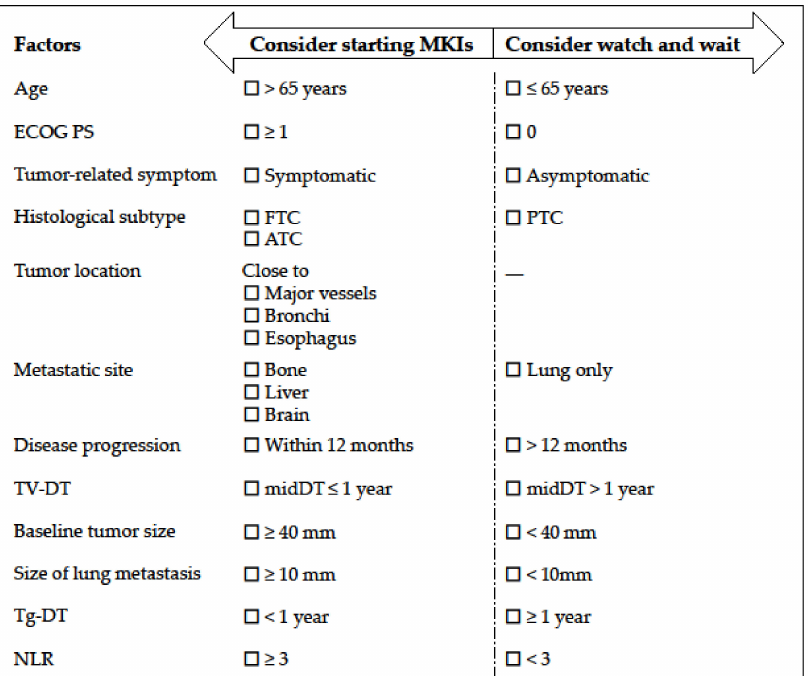
Figure 1. A simple check list of factors which can be potential indications for starting multi-kinase inhibitor treatment for radioactive-iodine refractory differentiated thyroid cancer. ECOG PS, Eastern Cooperative Oncology Group performance status; FTC, follicular thyroid cancer; ATC, anaplastic thyroid cancer; PTC, papillary thyroid cancer; TV-DT, tumor volume doubling time; midDT, average tumor volume doubling time; Tg-DT, thyroglobulin doubling time; NLR, neutrophil-to-lymphocyte